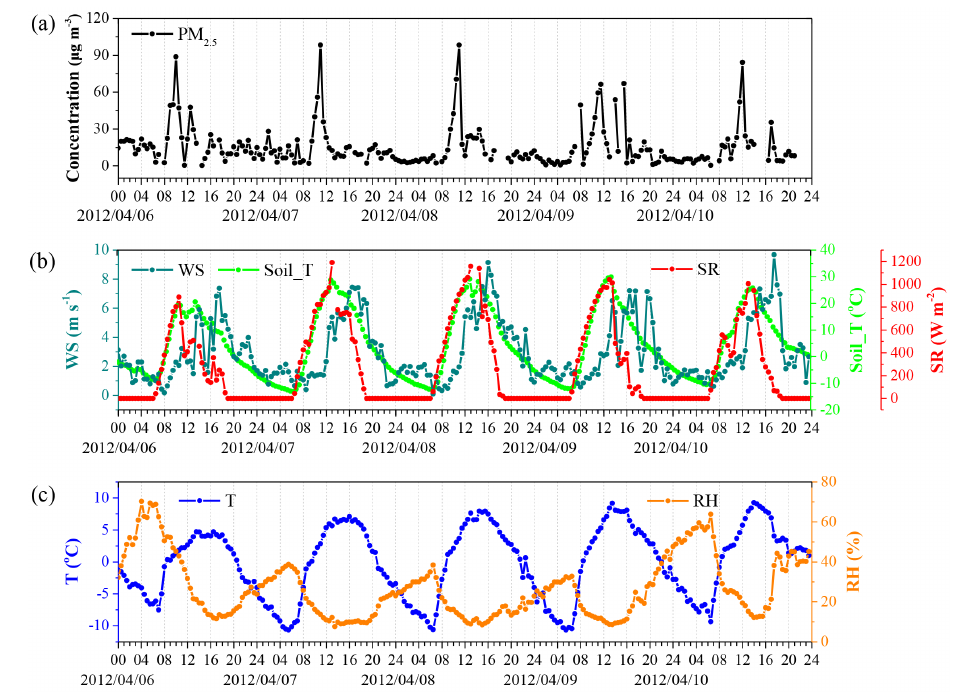
Figure 8. Diurnal variations in PM 2 . 5 masses and related environmental factors for 6–10 April 2012 at the Ngari station (located in a typical barren and arid area of inland Asia). SR is downward shortwave radiation and soil T is the surface soil temperature at 0cm. The local time (LT) and a 30min mean were